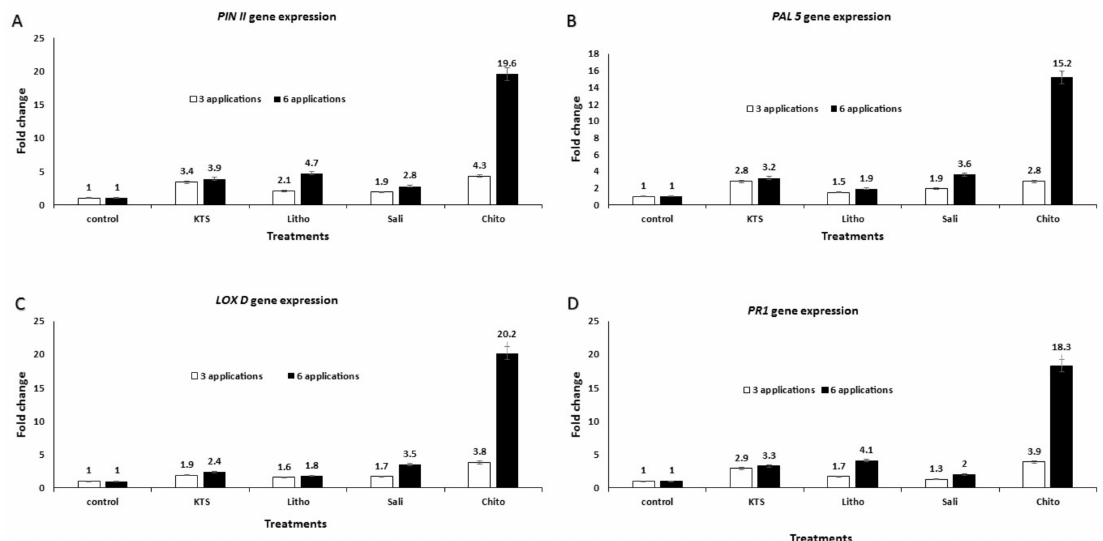
Figure 6. The e ff ect of the tested chemicals as a pre-harvest foliar application on gene expression profiling of associated-resistance genes in the treated tomato plants using qRT-PCR analysis. ( A ) PINII gene, ( B ) PAL5 gene, ( C ) LOXD gene and ( D ) PR1 gene fold change after three- and six-spray applications with K-thiosulfate (KTS) / 4 g L − 1 , Lithovit (Litho) / 4 g L − 1 , salicylic acid (Sali) / 1.5 g L − 1 , and chitosan (Chito) / 4 g L − 1 , respectively. The Actin gene was used as an internal reference gene for data normalization